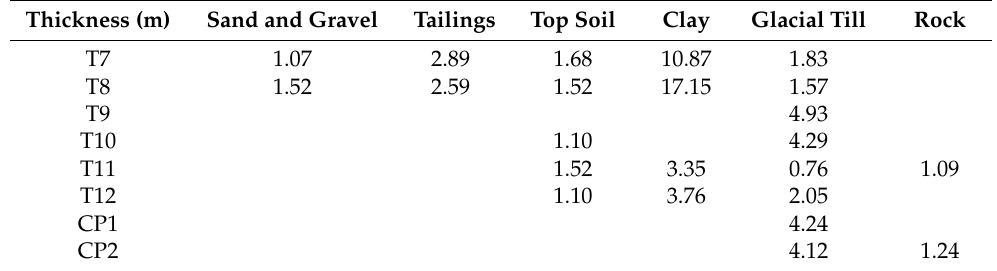
Table 1. The different layers encountered below the cover (from top to bottom) and their thicknesses. Thickness (m) Sand and Gravel Tailings Top Soil Clay Glacial Till